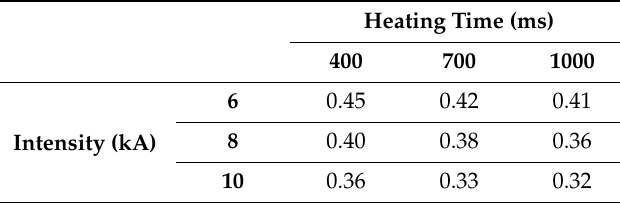
Table 1. Values of the compact final porosities ( Θ F ), expressed as a fraction, for di ff erent processing conditions.